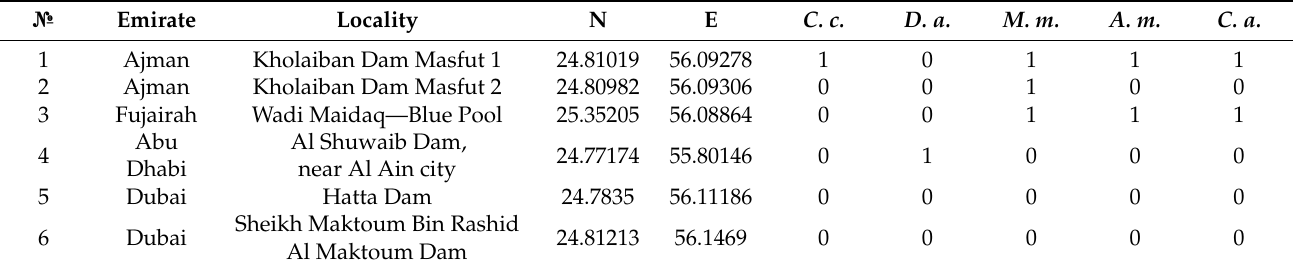
Table abbreviations: C.c. — Ceriodaphnia cf. cornuta ; D.a. — Daphnia arabica ; M.m. — Moina cf. micrura ; A.m. — Anthalona mediterranea ; C.a. — Coronatella anemae